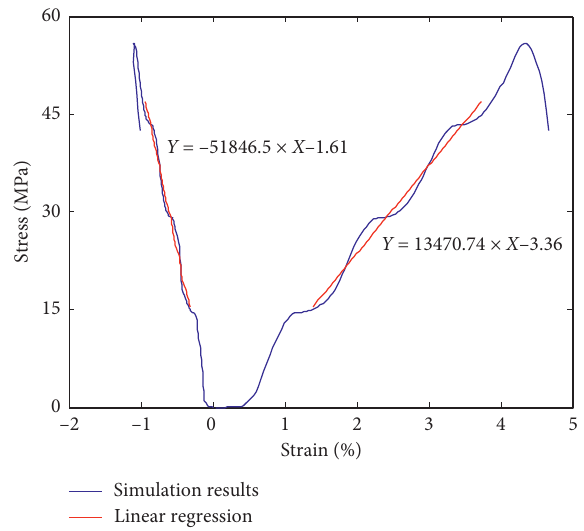
Figure 3: Stress to strain relationship of the cement grout